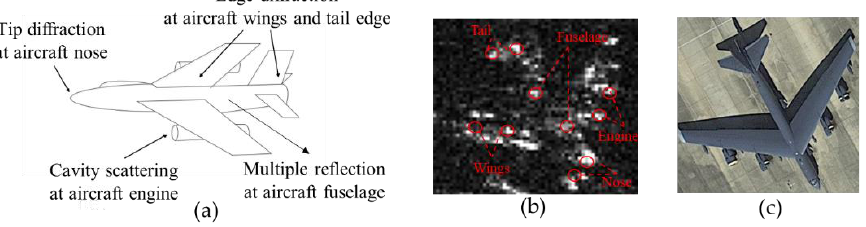
Figure 2. Scattering mechanism of aircraft in SAR images. ( a ) Scattering mechanism analysis of core components of aircraft. ( b ) SAR image of aircraft ( c ) Optical image of aircraft.